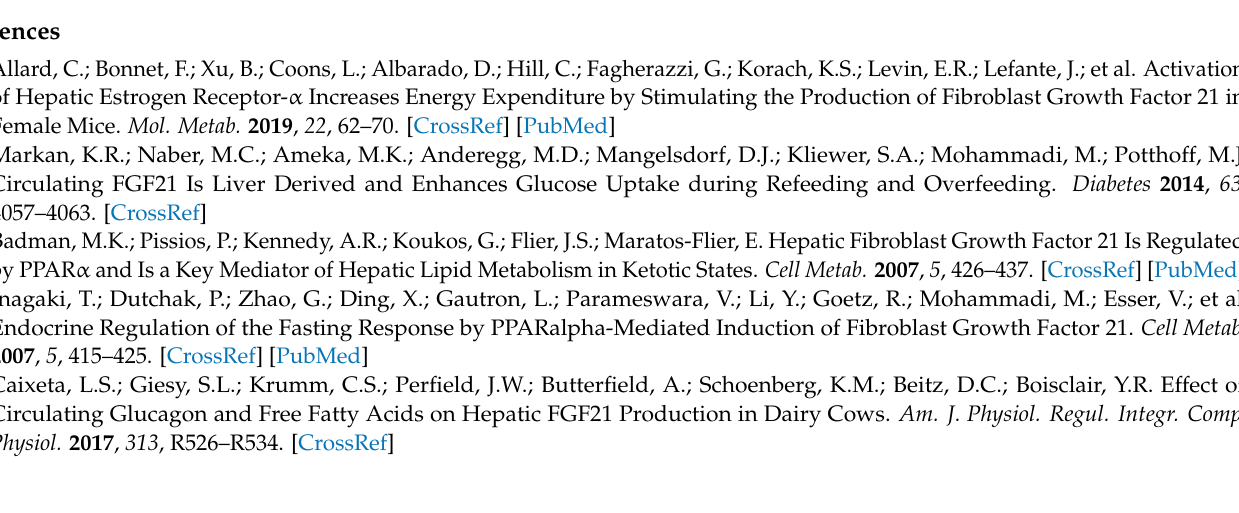
Characteristic of healthy eumenorrheic women. Table S2: Comparison of baseline variables between trimester of pregnancy. Table S3: Comparison of serum FGF-21 levels in three gestational periods and postpartum in healthy pregnant women and healthy non-pregnant women. Table S4: Comparison of serum FGF-21 levels in three gestational periods between healthy pregnant and preeclamptic women. Table S5: Pearson correlation coefficient between serum FGF-21 levels and study variables in pregnant women during the 1st, 2nd and 3rd trimester of pregnancy. Table S6: Pearson’s correlation coefficient between serum FGF-21 levels and study variables in healthy eumenorrheic women during the early follicular and mid-luteal phase of the menstrual